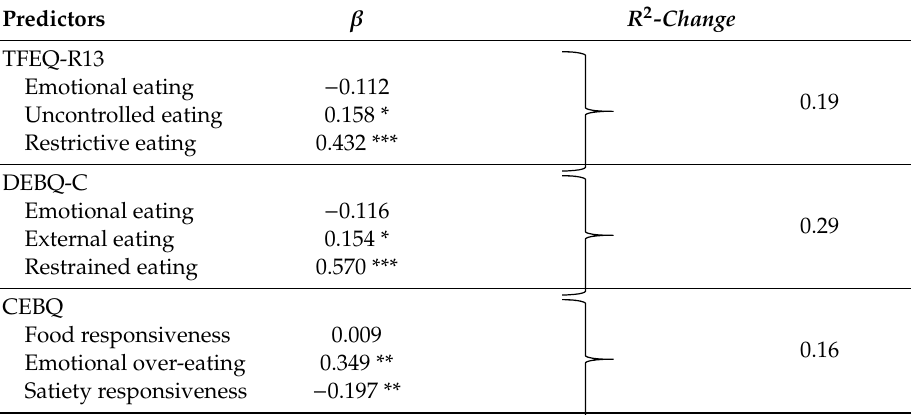
Table 2. A child–mother dyadic perspective: An analysis of the predictors of BMI. Predictors β R 2 -Change TFEQ-R13